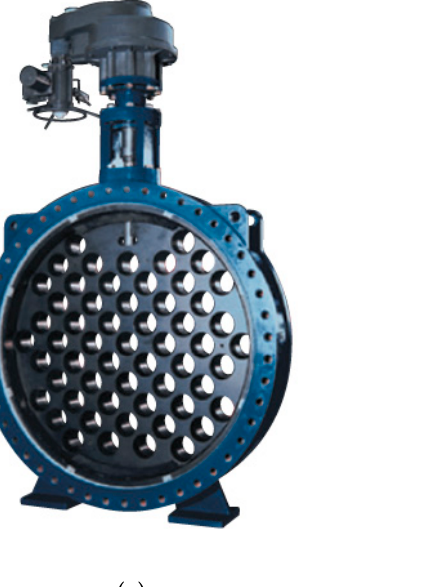
Figure 10. Energy loss coefficient vs. % valve opening for a multi-jet valve [44].